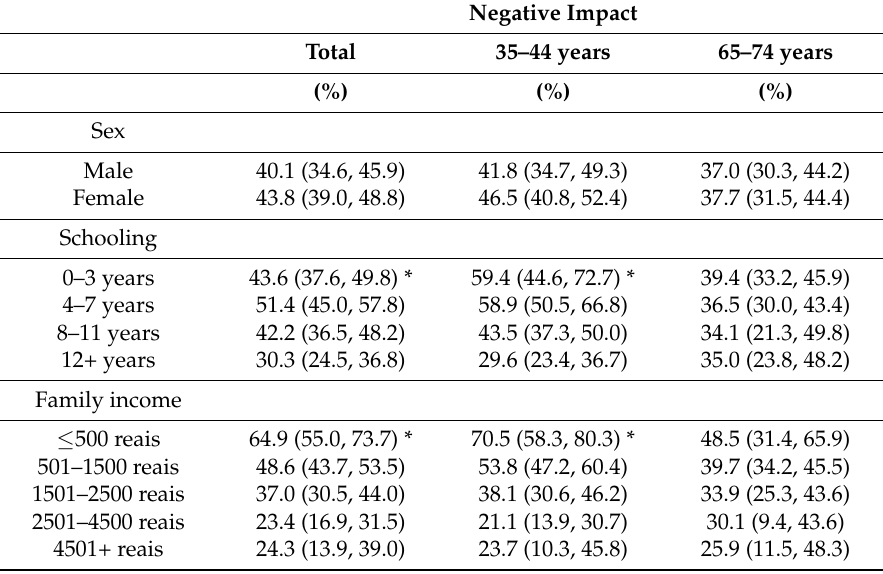
Table 2. Negative impact of oral health on quality of life according to socioeconomic and demographic